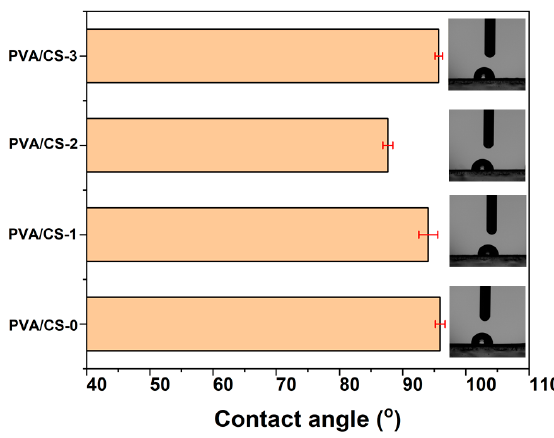
Figure 3. Microscopic images of the composite films and histograms generated by Alpha-Step D- 500 Stilus profilometer ( a ) PVA/CS-0; ( b ) PVA/CS-1; ( c ) PVA/CS-2; ( d ) PVA/CS-3. The wetting characteristics, such as work of adhesion (Wa), the total solid surface free energy ( γ SV ), solid-liquid interfacial tension ( γ SL ), etc., of the PVA/CS samples with respect to the W and EG were investigated. A summary of all contact angle study param- eters is provided. Table 2 provides a summary of all the contact angle investigations’ pa- rameters. W and EG were used as the test liquids, whereas PVA samples were examined using contact angle measurements at room temperature. Figure 4 displays the results of measuring the contact angle for the PVA sample in W.